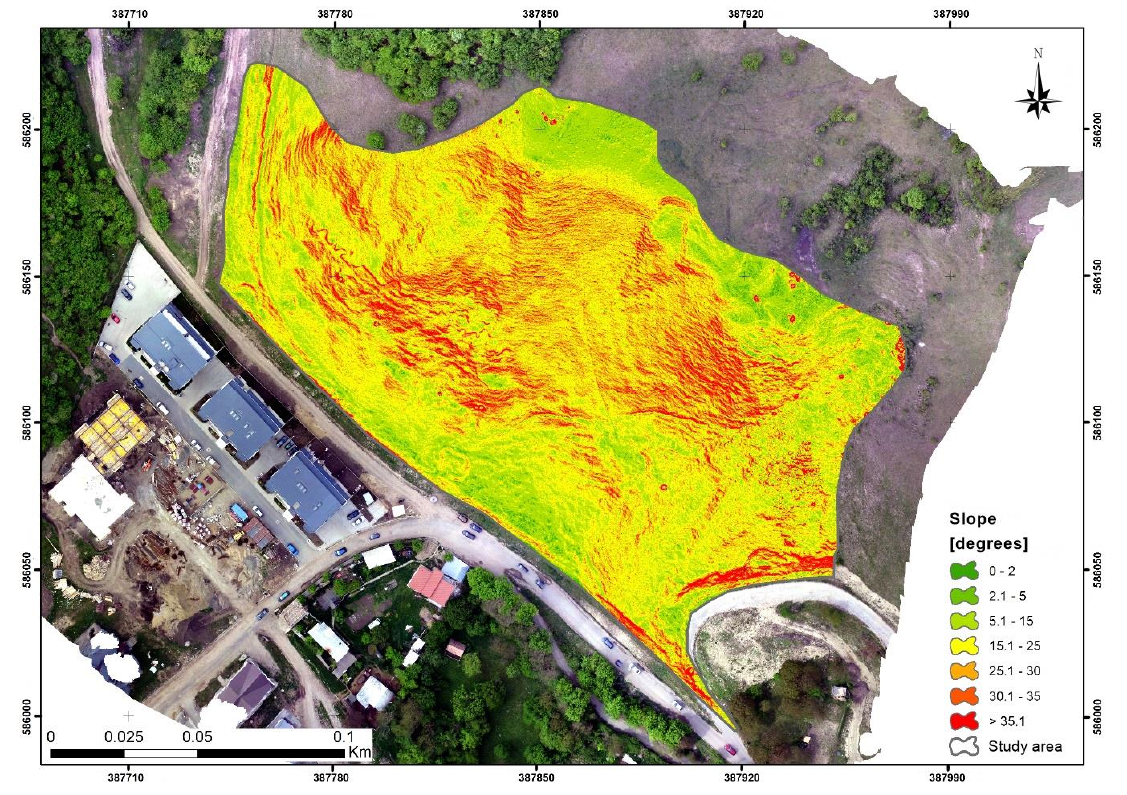
Figure 15. Slope of the study area.